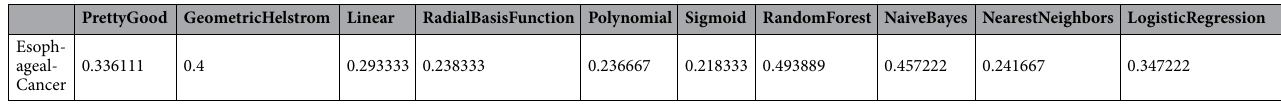
Table 9. Case-control study of esophageal